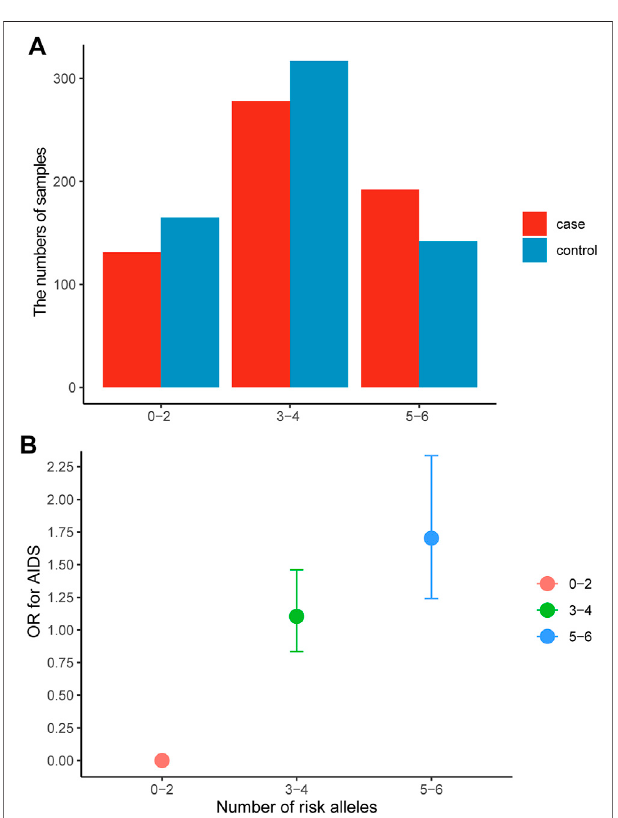
FIGURE 3 | Association between the number of risk alleles in rs1130409, rs1001581 and rs25487 and AIDS. (A) the numbers of patients and healthy individuals with each risk allele in cases and controls, (B) The risk of AIDS by the number of risk allele categories. Data are crude ORs and 95% CIs. The 0 – 2 group was the reference. OR = odds